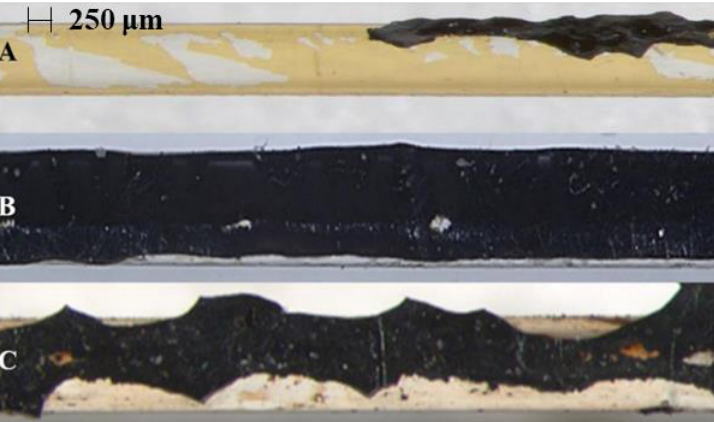
Figure 5. Coverage images of 50% PPOL on PET monofilament without activation (250 µm) ( A ), with plasma activation ( B ) and with Epoxy + RFL activation ( C ).